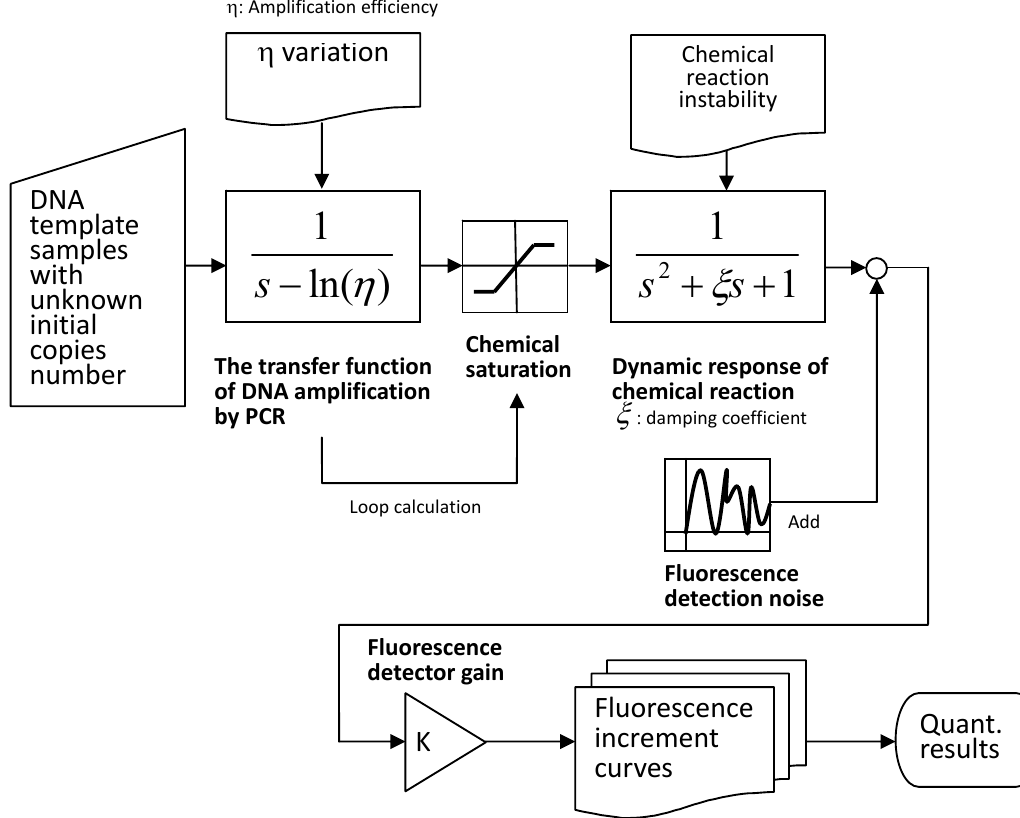
Figure 5. The system identification model developed to simulate the real-time PCR machine and the noise factors are indicated as the DNA amplification efficiency ( η) variation, the chemical reaction instability caused different damping coefficient ( ξ ) and the fluorescence detection noise. With this model, numerical experiments can be conducted to evaluate the instrument